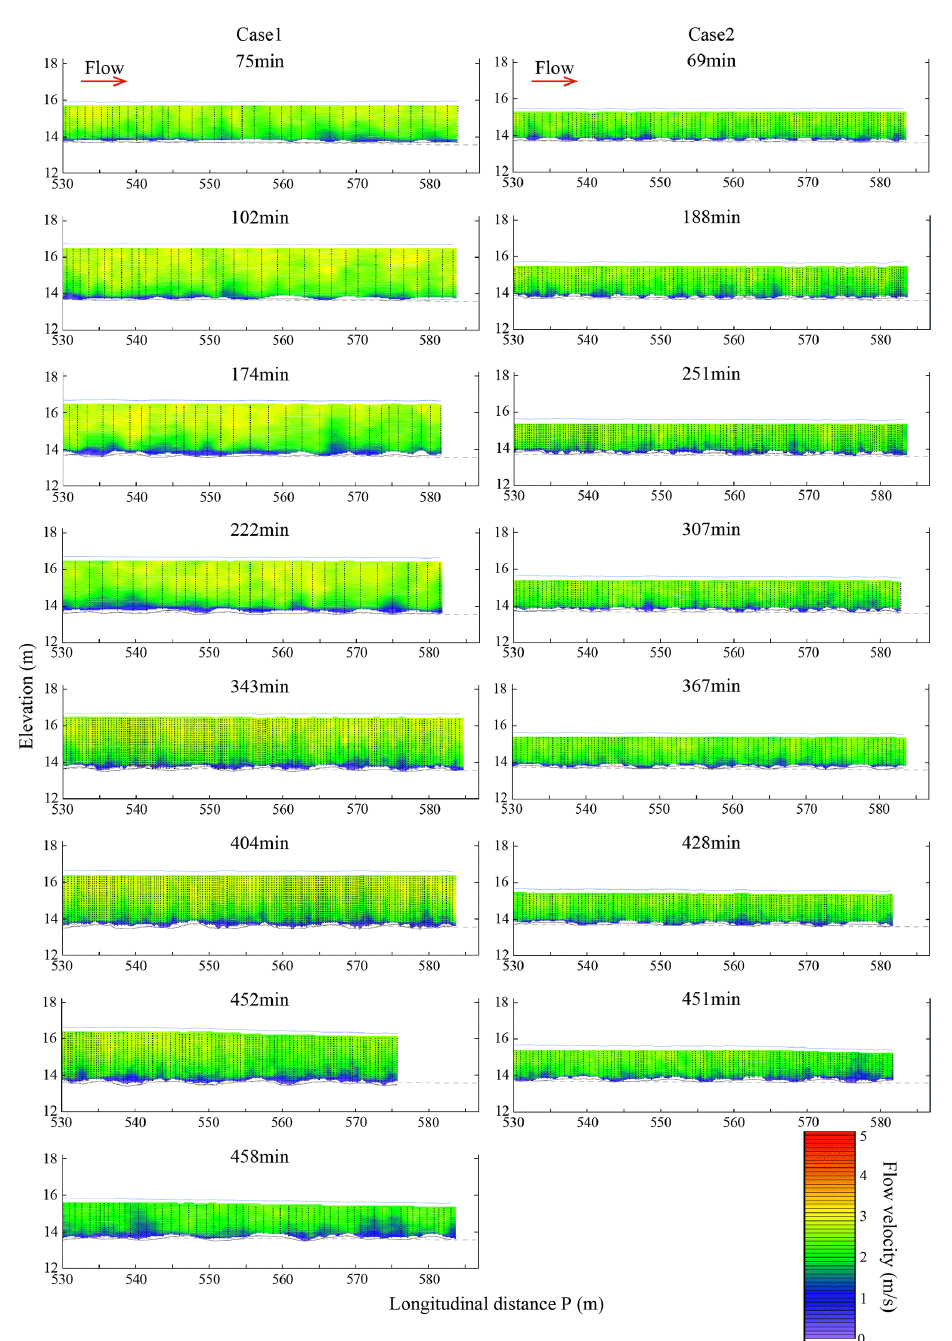
Fig. 5. Velocity distribution observed by longitudinal ADCP measurement. Left: Case 1, Right: Case